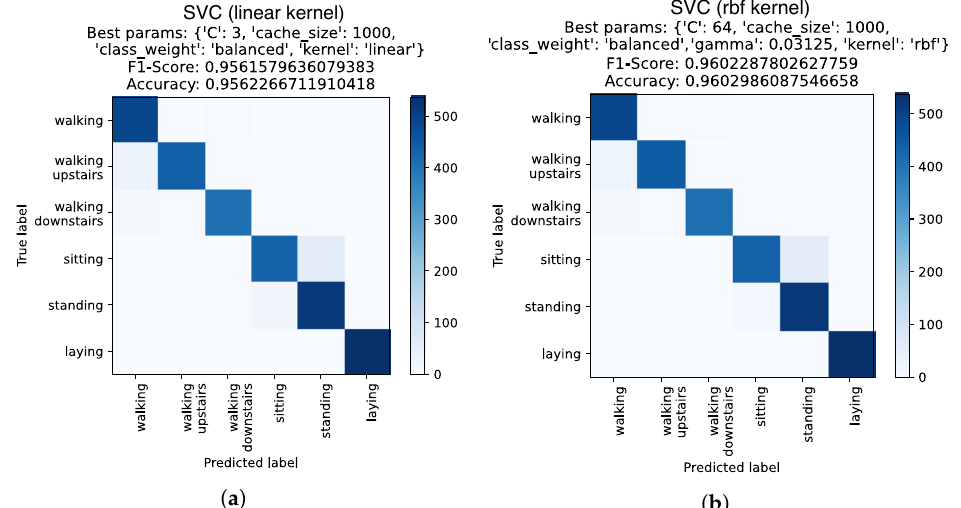
Figure 9. Confusion matrices of the best performing SVM models with its hyperparameters. ( a ) Sup- port Vector Machine (linear kernel). ( b ) Support Vector Machine (RBF